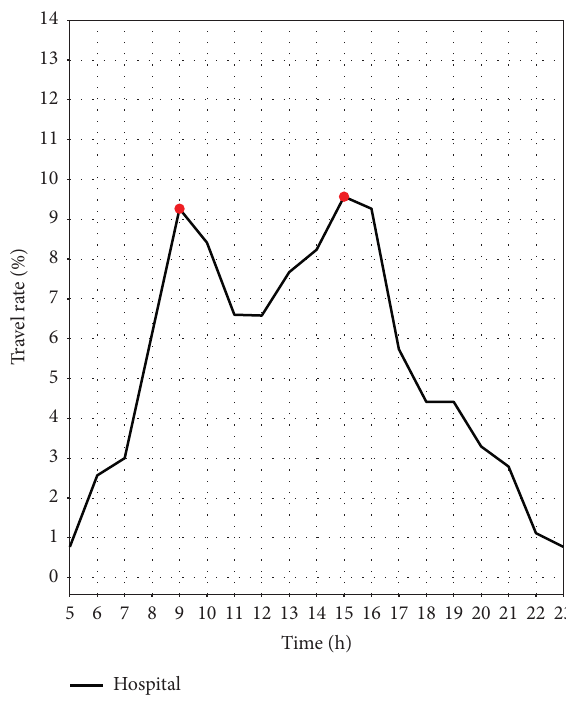
Figure 9: Hourly travel rate of cluster 1.